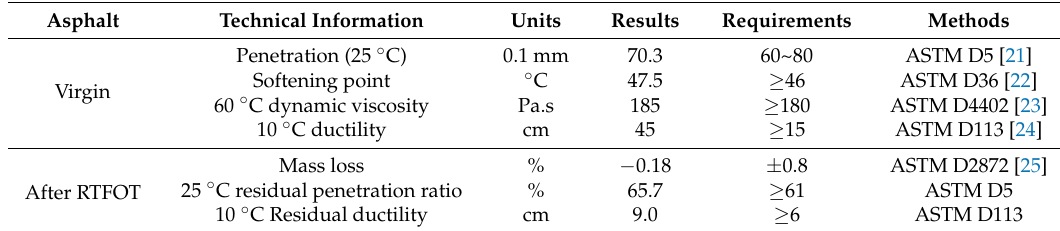
Table 1. Technical information on GF-70.